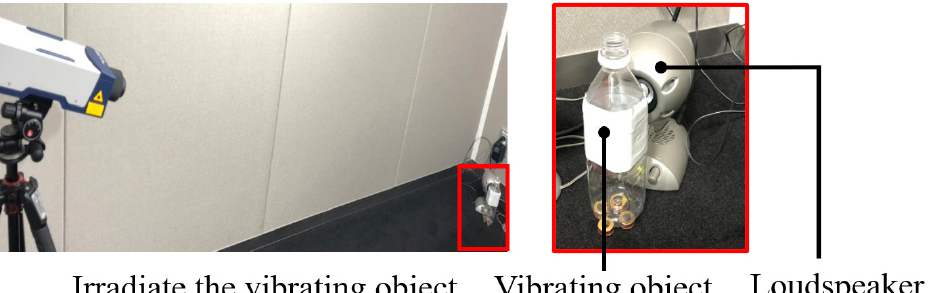
Figure 9. Experimental setup.